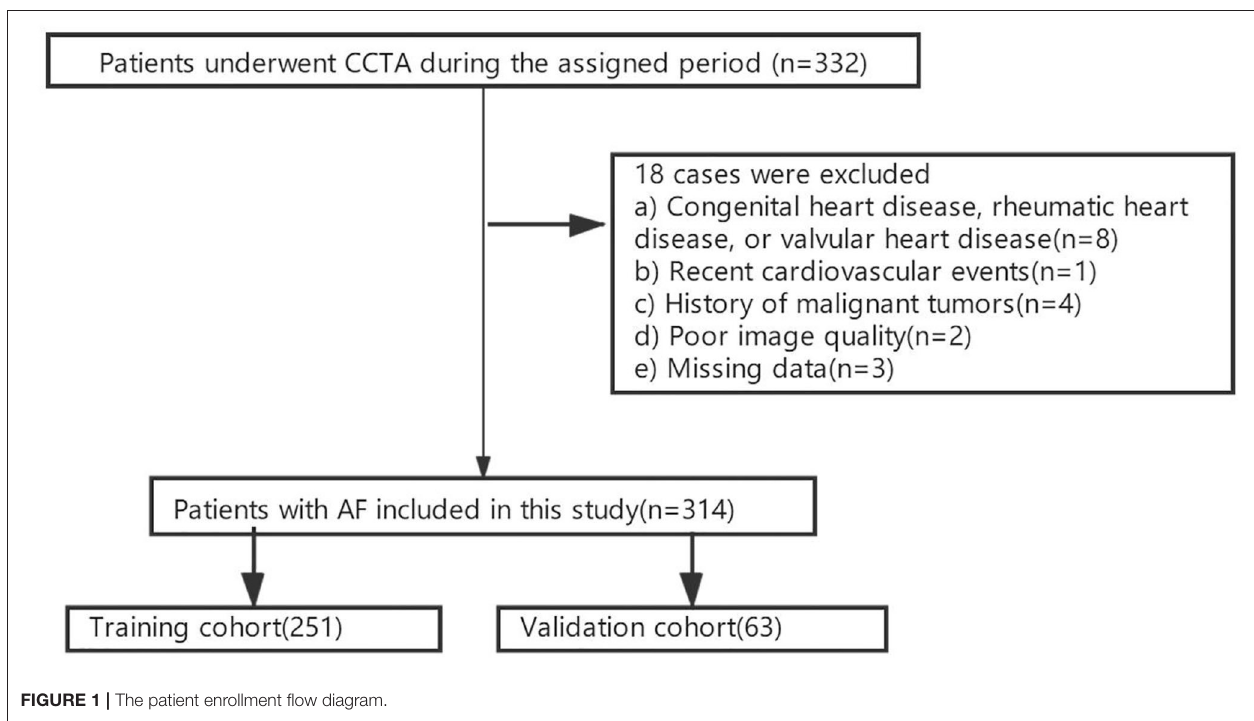
FIGURE 1 | The patient enrollment flow diagram.